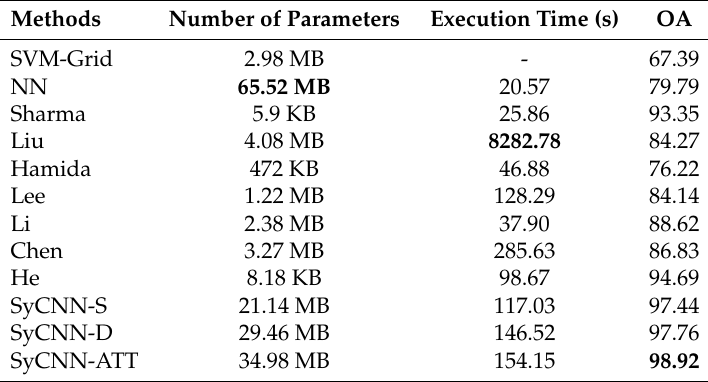
Table 7. Comparison of parameters and times of all